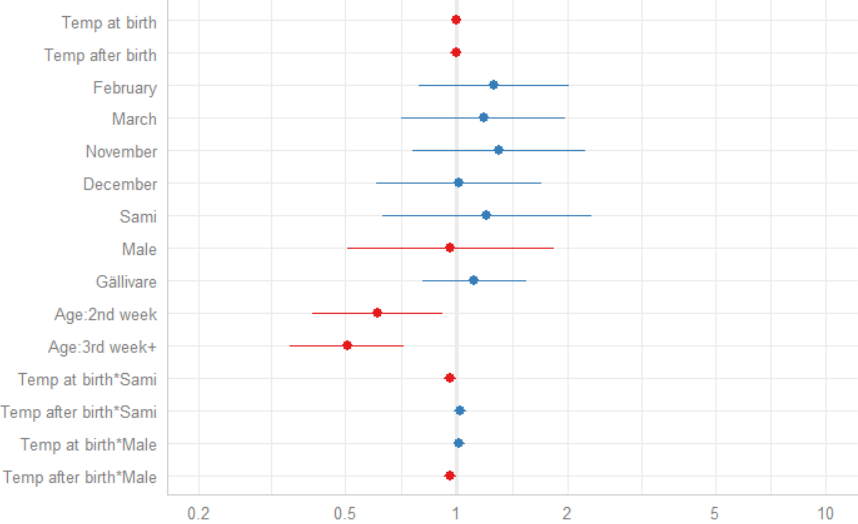
Figure 3. Hazard ratios of neonatal mortality with 95% confidence intervals (blue=increased hazard ratio, red=decreased hazard ratio), November–March, 1860–1899.